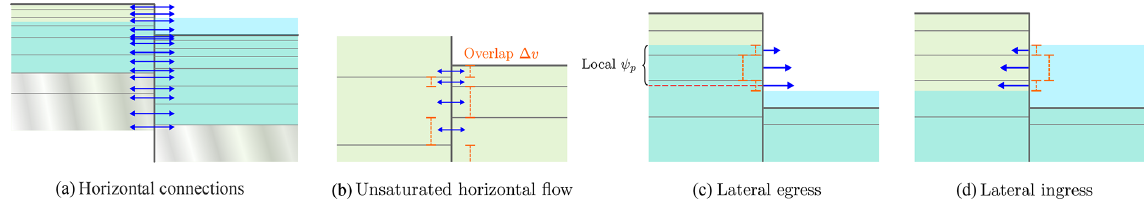
Figure 3. The lateral flow scheme. Fluxes are calculated horizontally for connections where layers overlap in the same manner as for the vertical fluxes in JULES (b) . Fluxes are only permitted when they are into an unsaturated layer. Where high tile layers are above the low tile soil surface, flow can occur horizontally out of the soil (c) or from the pond to the soil (d)